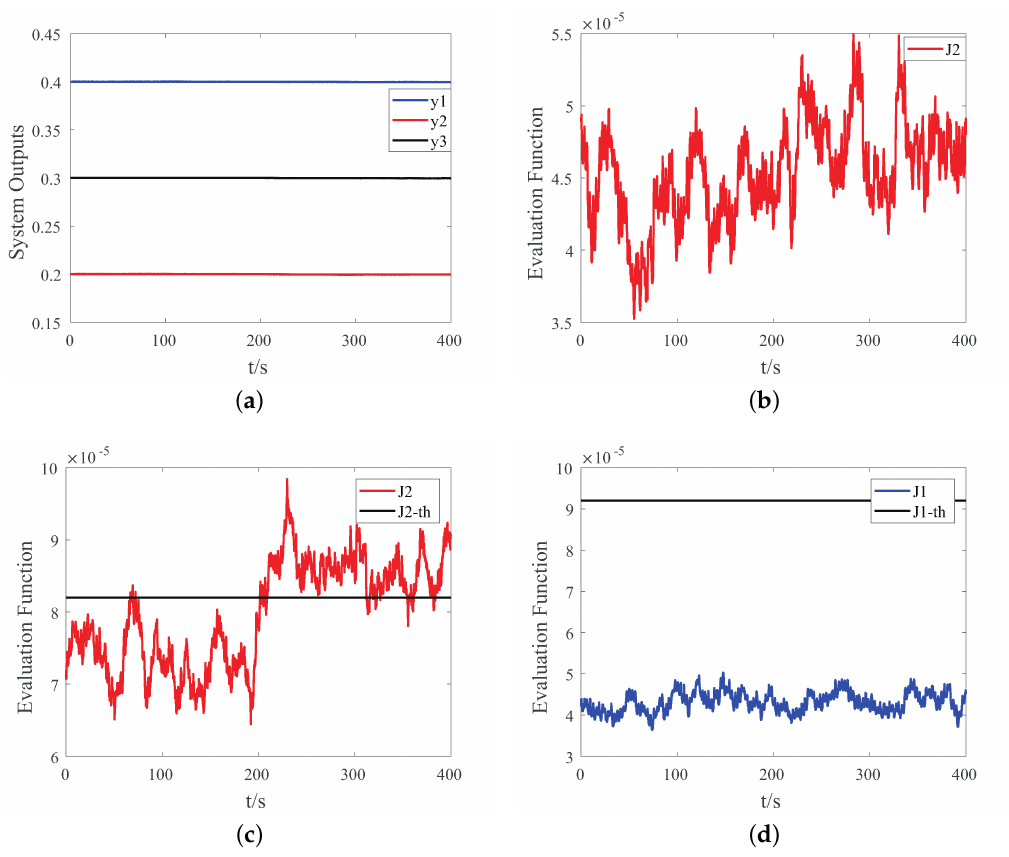
Figure 5. Simulation results of the system with fault mode i = 2 occurring at 200 s: ( a ) system outputs without auxiliary signals; ( b ) the evaluation function J [ 2 ] without auxiliary signals; ( c ) the evaluation function J [ 2 ] with auxiliary signal a [ 2 ] ; ( d ) the evaluation function J [ 1 ] with auxiliary signal a [ 2 ]